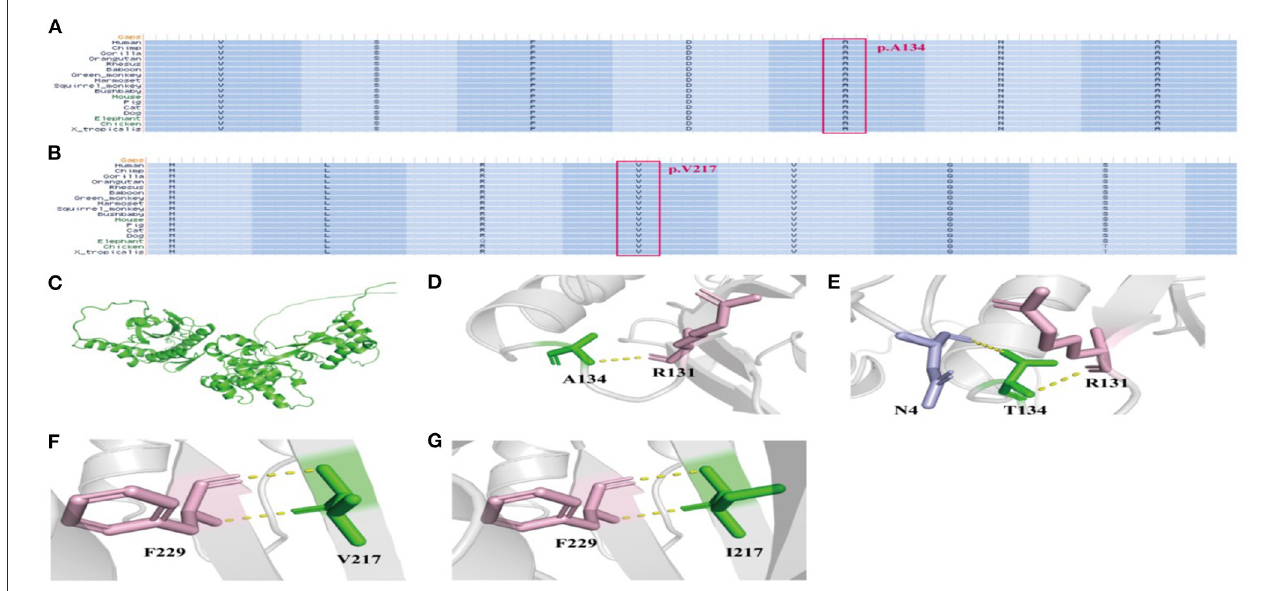
FIGURE3 The conservation assessment of NPRL3 mutation sites and the NPRL3 protein tertiary structure. (A) The conservation assessment of c.400G > A (p.Ala134Thr). (B) The conservation assessment of c.649G > A (p.Val217Ile). (C) The 3D structure of wild type and mutant type of NPRL3 protein structure. (D, E) The NPRL3 protein tertiary structure of c.400G > A mutation. (F, G) The NPRL3 protein tertiary structure c.649G > A